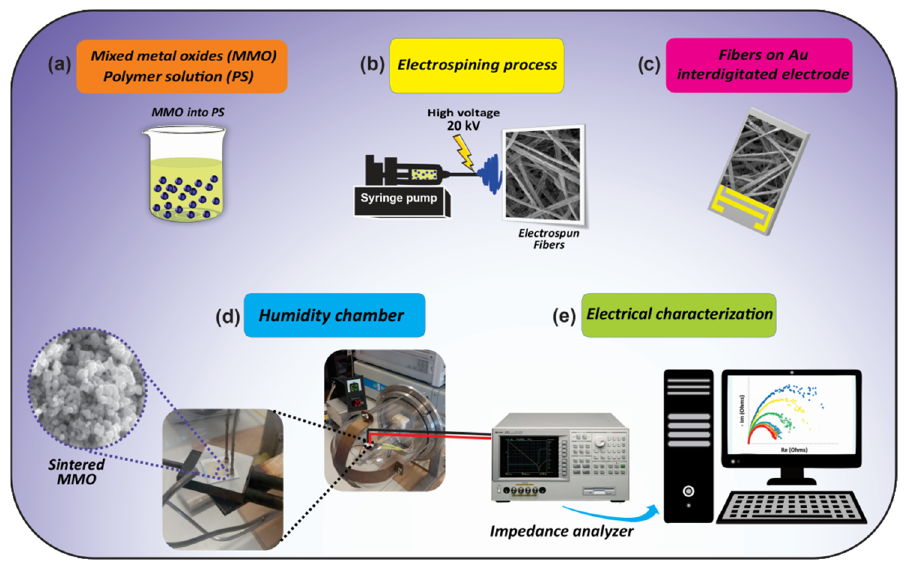
Figure 1. Illustration of the samples preparation for moisture sensing tests: ( a ) Polymeric solution containing the mixed metal oxides (MMO) for the ( b ) electrospinning process; ( c ) deposition of the electrospun fibers (containing the oxides) on the Au interdigitated electrode; ( d ) sintered oxides for electrical tests in the humidity chamber; ( e ) RH dependent electrical response.